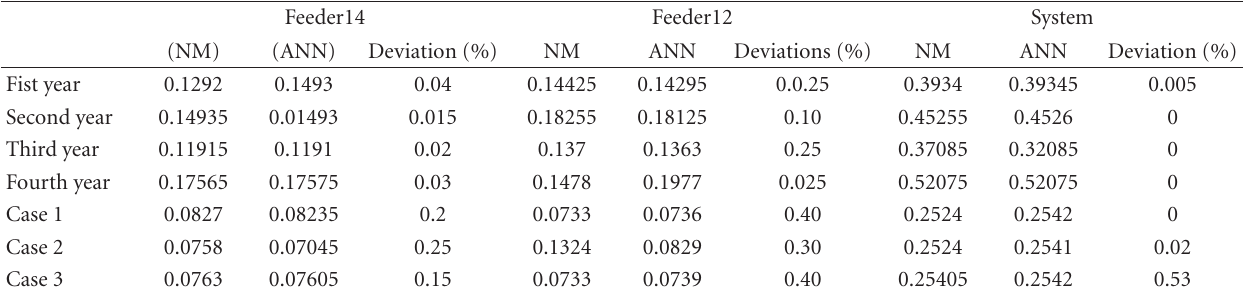
Table 2: System average interruption frequency index values (SAIFI).